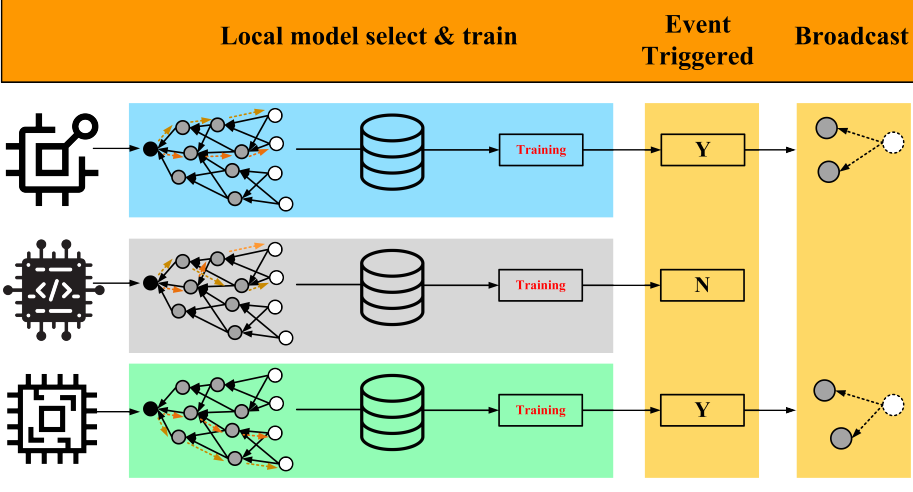
Figure 2. Workflow of the Energy Efficient SDAGFL